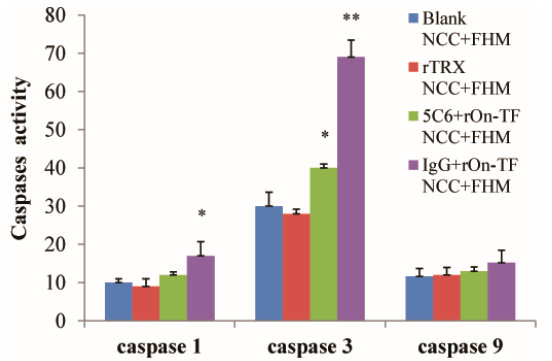
Figure 8. Effect of caspase-1, 3, and 9 activities in FHM cells by rOn-TF-activated NCC. Value represented as mean ± S.E, n = 3. Significant difference is expressed as follows: * 0.05 > p > 0.01, ** p < 0.01.